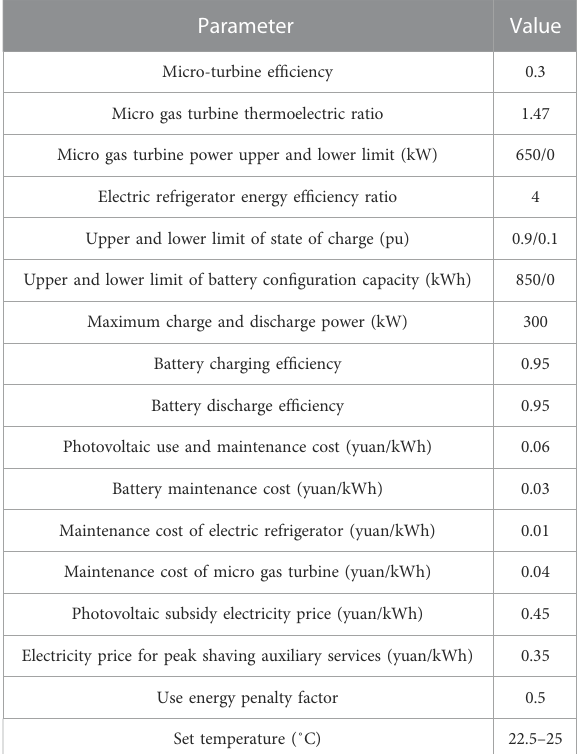
TABLE 1 Equipment electrical